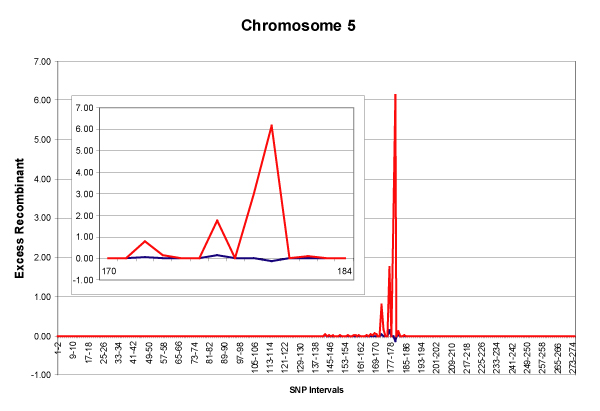
Distribution of excess recombinants. The red curve uses the Affymetrix genotype (tsc0260848) at marker 180. The blue curve uses the Illumina genotype (rs958883) at marker 180. The inset shows an enlarged view of the excess number of inferred recombinants in the neighborhood of rs958883/tsc0260848.